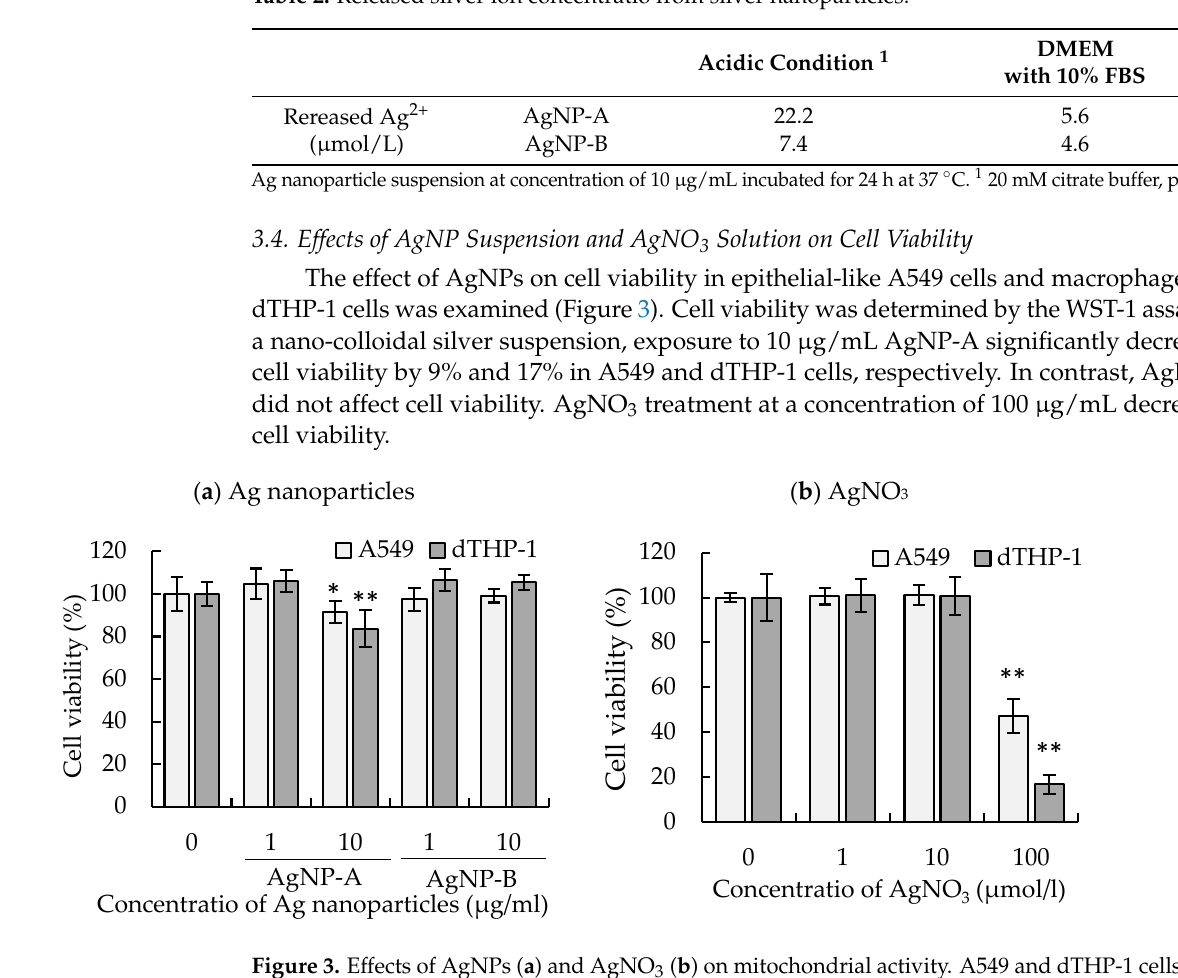
Figure 3. Effects of AgNPs ( a ) and AgNO 3 ( b ) on mitochondrial activity. A549 and dTHP-1 cells were treated with AgNP suspensions at 1 and 10 µ g/mL, or with AgNO 3 solution at 1, 10, and 100 µ mol/L. After incubation for 24 h, the WST-1 assay was conducted. The percentage of WST-1 was normalized to that in standardized untreated cells (100%). ** p < 0.01, * p < 0.05 (vs. untreated cells, ANOVA and Dunnett’s test).